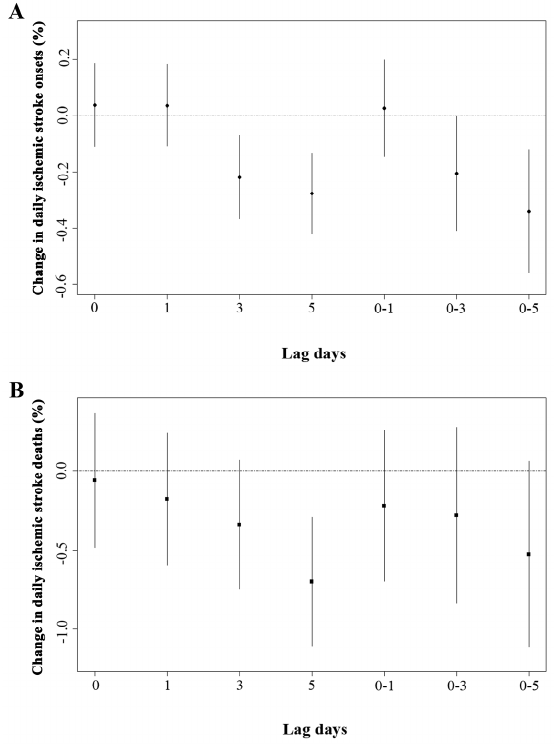
Figure 2. The percentage changes in daily ischemic stroke onsets ( A ) and deaths ( B ) with per interquartile range increment in O 3 concentrations at different lag days in single-pollutant models in Changzhou, 2015–2016. The data was expressed as mean with 95% confidence interval. O 3 indicates ozone .